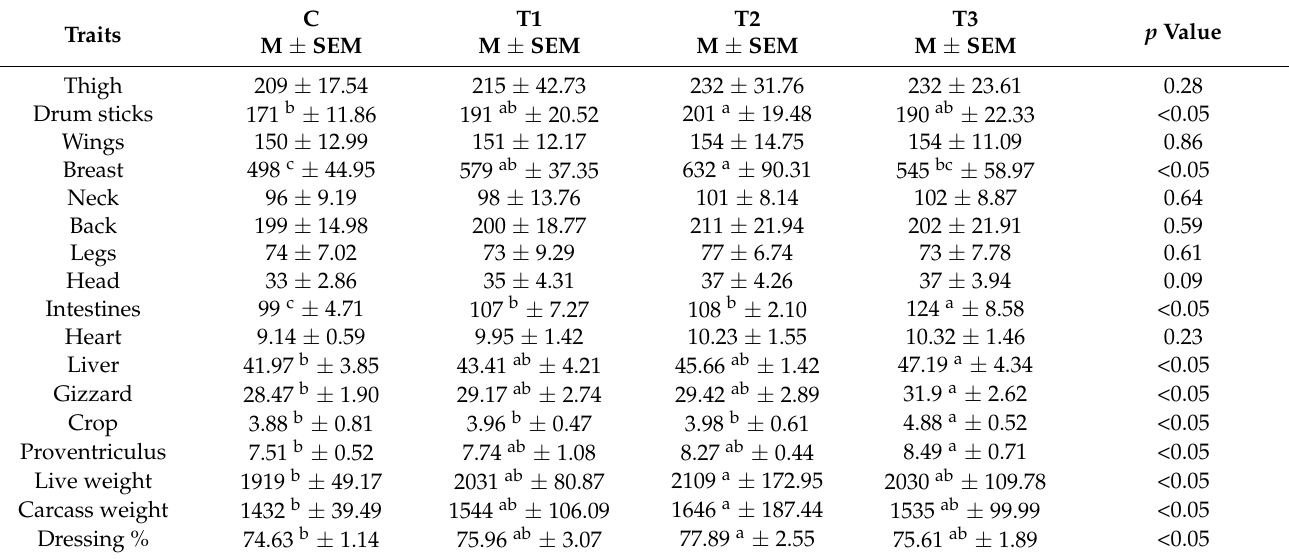
Table 5. Effect of black cumin seed meal and coconut meal on the relative weight of broiler cuts and organs (g/carcass